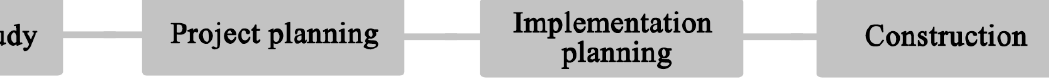
Figure 1. Four phases of wooden additional floor construction.